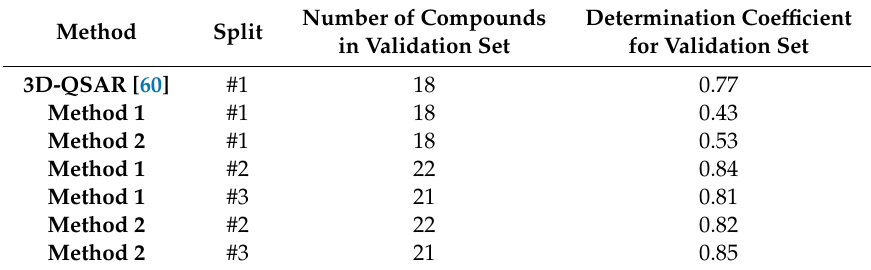
Determination Coe ffi